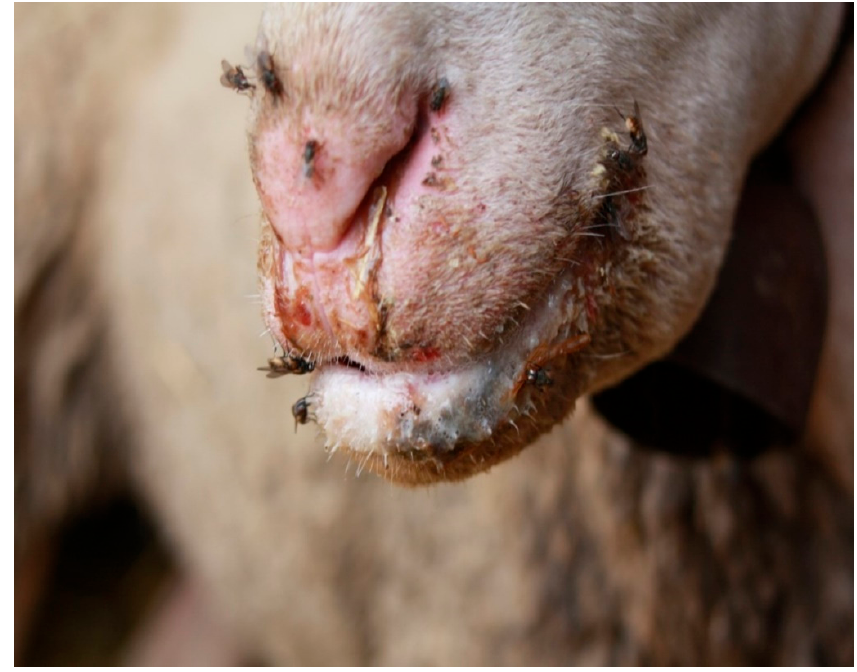
Figure 3. House flies feed on buccal lesions and saliva of ORFV-infected sheep during an outbreak. Observations and Limitations of the Study